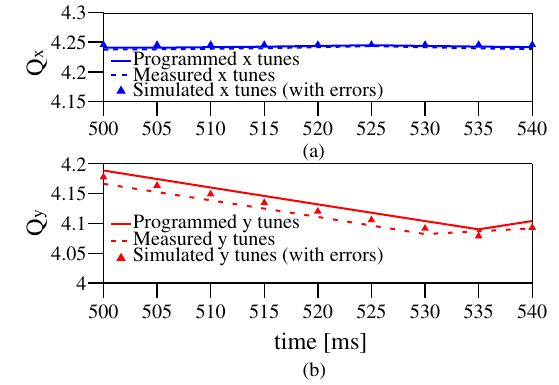
FIG. 17. The dynamic approach to Q y ¼ 4 : horizontal (a) and vertical (b) tunes vs